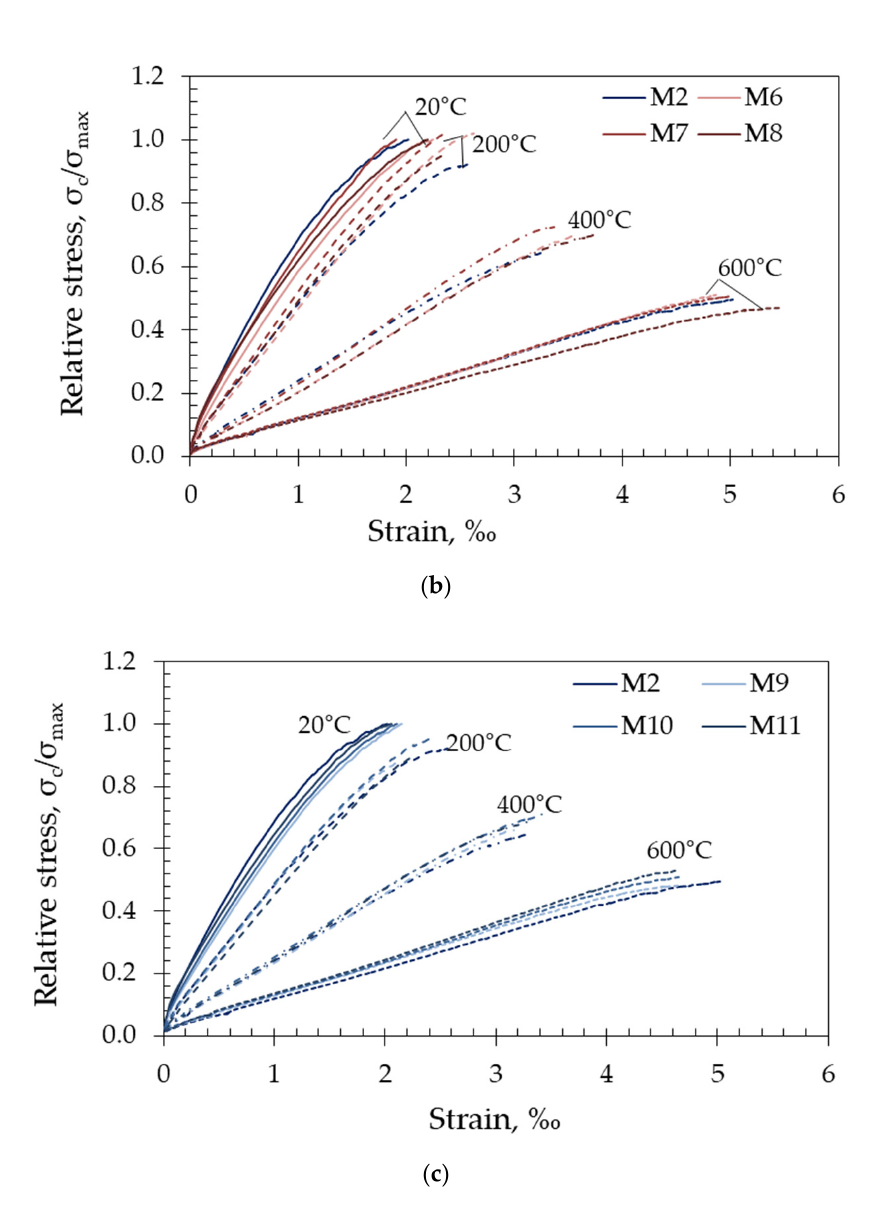
Figure 8. Normalised stress–strain curves for ( a ) metakaolin based (M3–M5), ( b ) fly-ash based (M6–M8) and ( c ) limestone based (M9–M11) in relation to the reference mixture (M2) as a function of temperature.